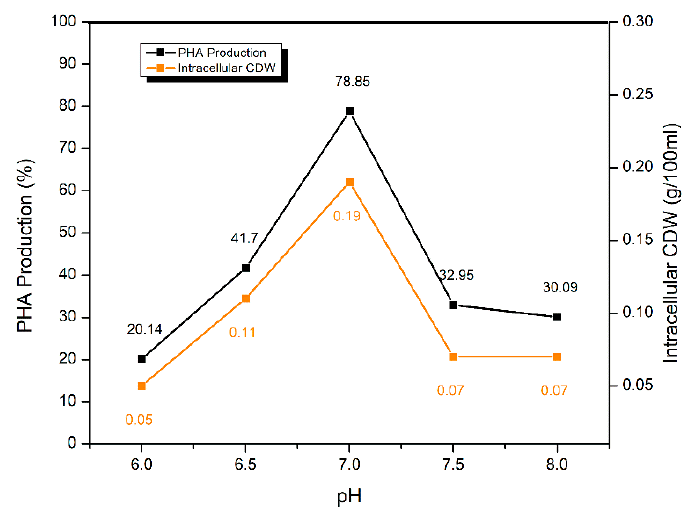
Figure 7. Optimization pH of fermentation medium for PHA production by S. maltophilia HA-16 with glucose as carbon source .